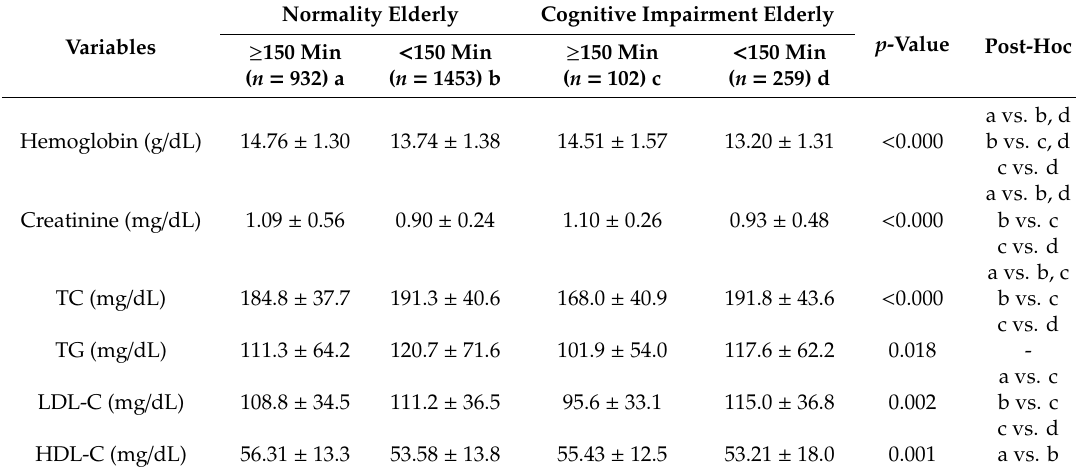
Table 3. Blood variables for each group.